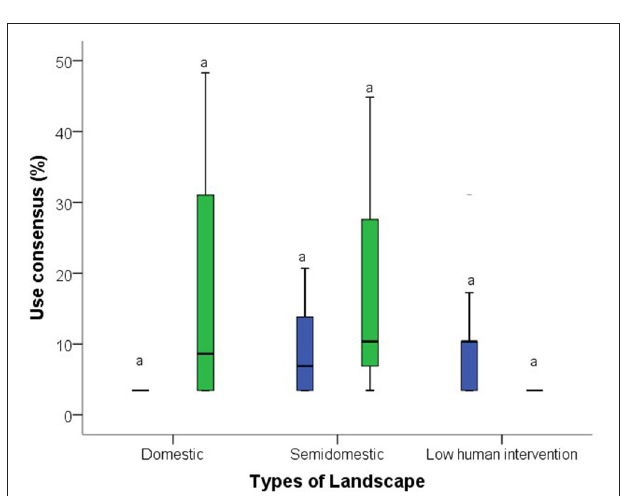
different categories of landscape ( p > 0.05).